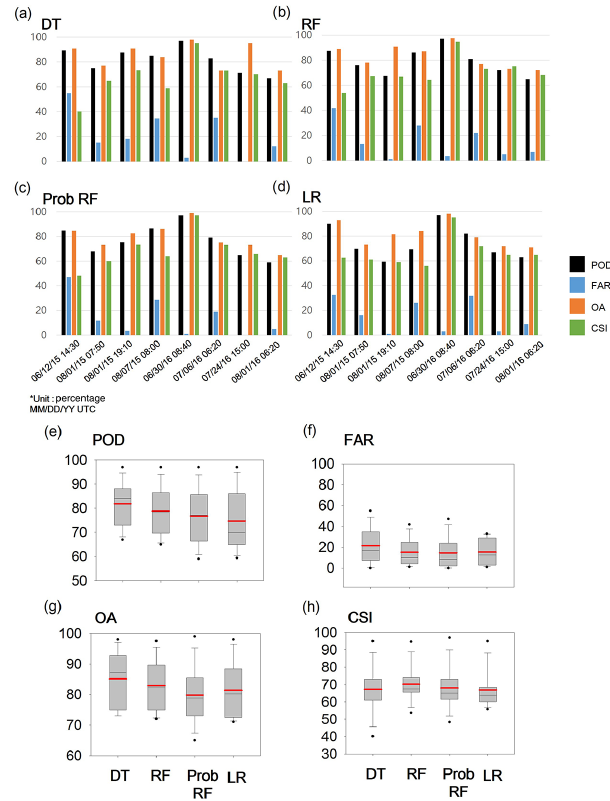
Figure 7. Validation metrics based on radar CAPPI data for the (a) deterministic DT and (b) RF, (c) probabilistic RF, and (d) LR models. Box plots of validation metrics based on radar CAPPI data for (e) POD, (f) FAR, (g) OA, and (h) CSI. While red lines in the boxes represent mean values, grey lines represent median values.